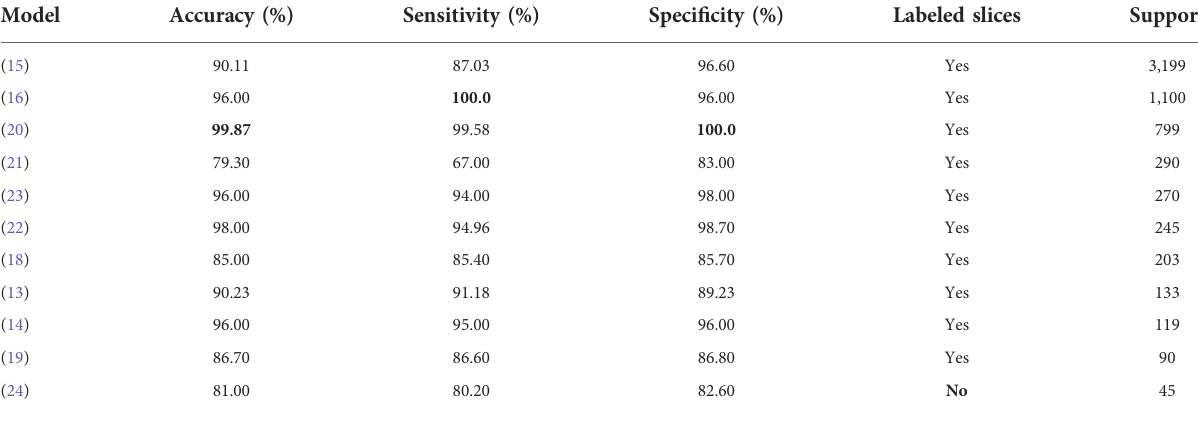
TABLE 1 Performance comparison among COVID-19 lung CT classi fi cation models, as reported by the authors, on their test sets. Where multiple classi fi ers were tested, the results without data augmentation are reported.